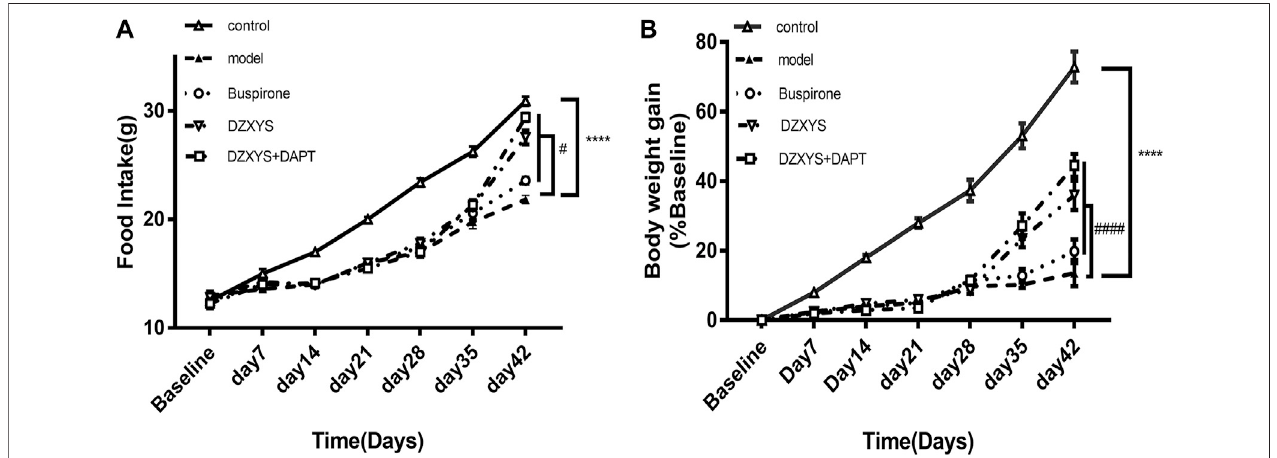
FIGURE 3 | Food intake of rats (A) and body weight growth rate (B) of rats in each group at the end of stress and drug intervention up to the 42nd day. Control: control group (Hollow triangle); model: model group (Solid triangle); Buspirone: Buspirone group (Hollow circle); DZXYS: DZXYS group (Inverted hollow triangle); DZXYS + DAPT: DZXYS + DAPT Group (Hollow square); **** p < 0.0001 vs control group. # p < 0.05, #### p < 0.0001 vs model group.